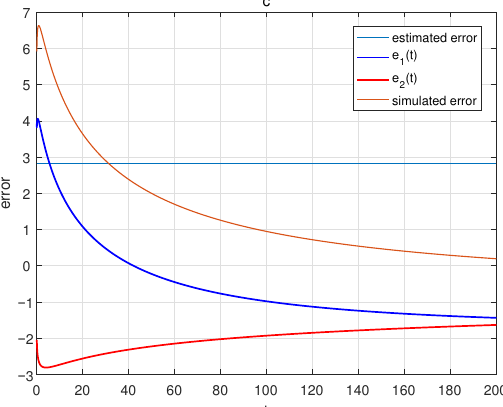
Figure 2. The state of error system when g i = 2, β 1 = 1.5, β 2 =